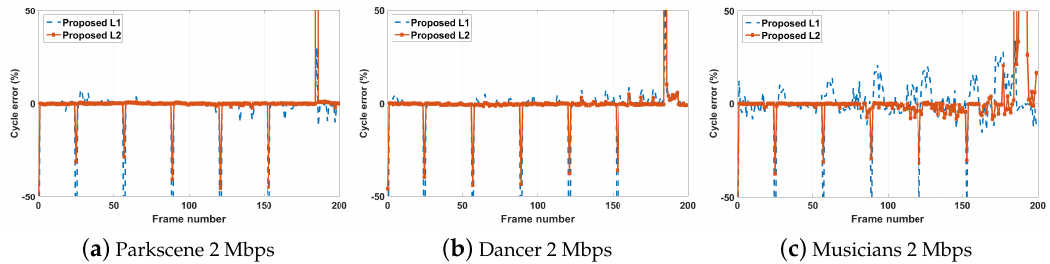
Figure 3. An illustration of the frame-wise percentage error between the target decoding-complexity and the achieved decoding-complexity for the proposed algorithm at two complexity levels for a given bit rate (2 Mbps) for ( a ) Parkscene, ( b ) Dancer and ( c ) Musicians test sequences. Table 2. Decoding-complexity-controlling performance of the proposed encoding algorithm. Proposed